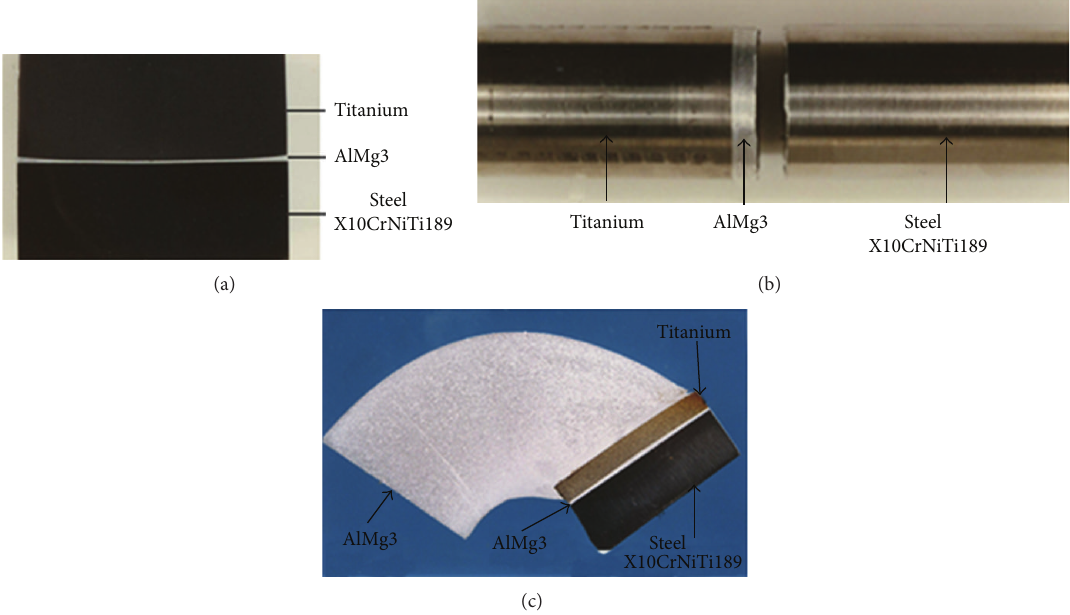
Figure 20: The view of a macrostructure of a friction welded titanium-AlMg3-X10CrNiTi189 joint (a), a joint after the tensile test (b), and an AlMg3-titanium-AlMg3-X10CrNiTi189 joint after the technological bending test (c) (according to [13]). Table 2: The chemical compound of the tested materials (according to [14]). Material